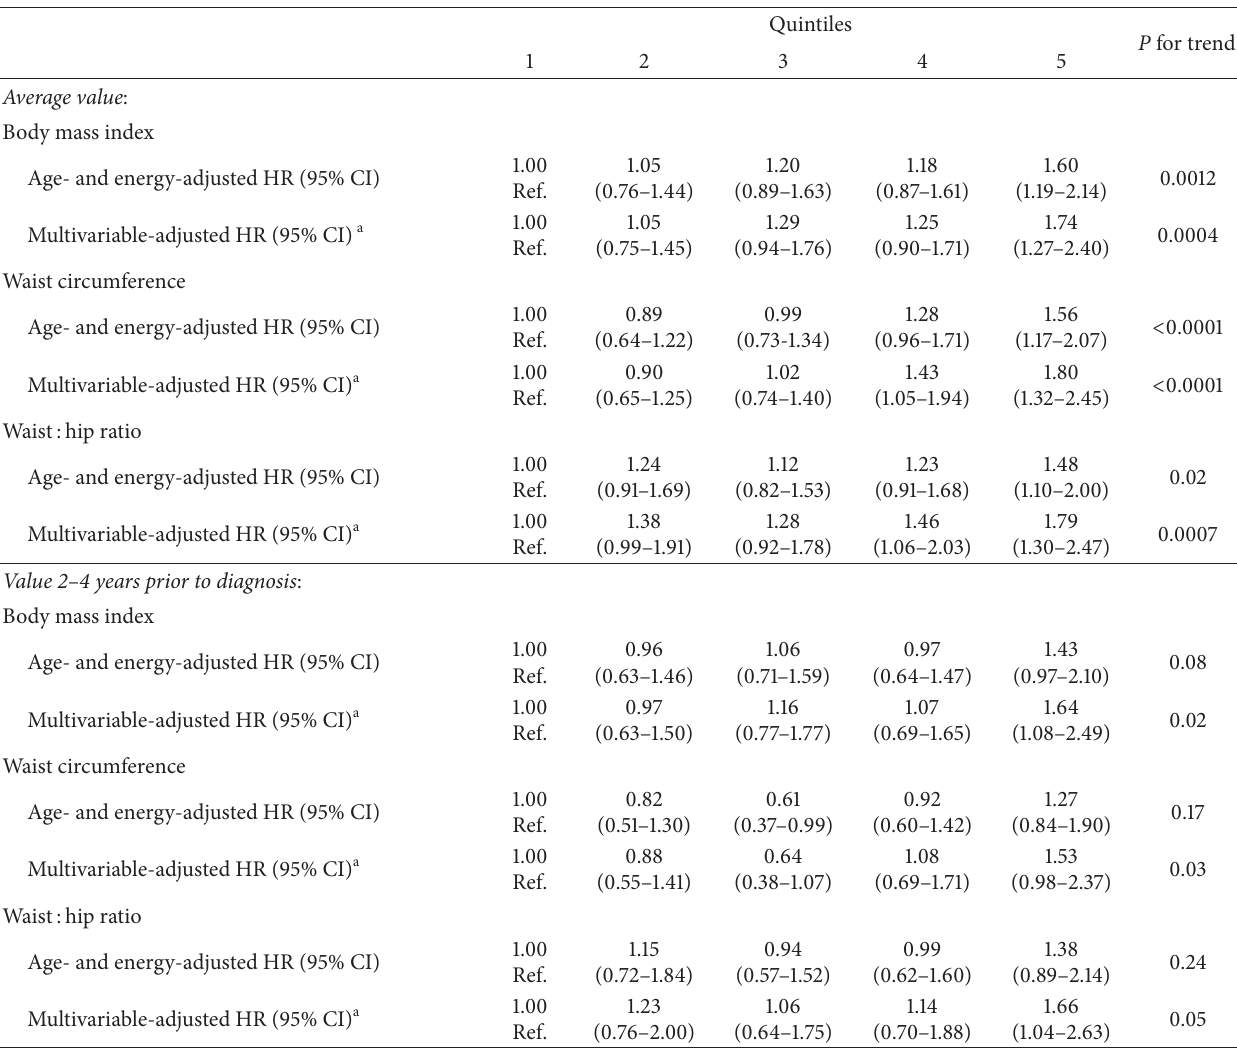
Table 6: Hazard ratios (HR) and 95% confidence intervals (CI) from time-dependent covariate analysis of the association of body mass index, waist circumference, and waist-hip ratio with risk of incident, invasive breast cancer in postmenopausal